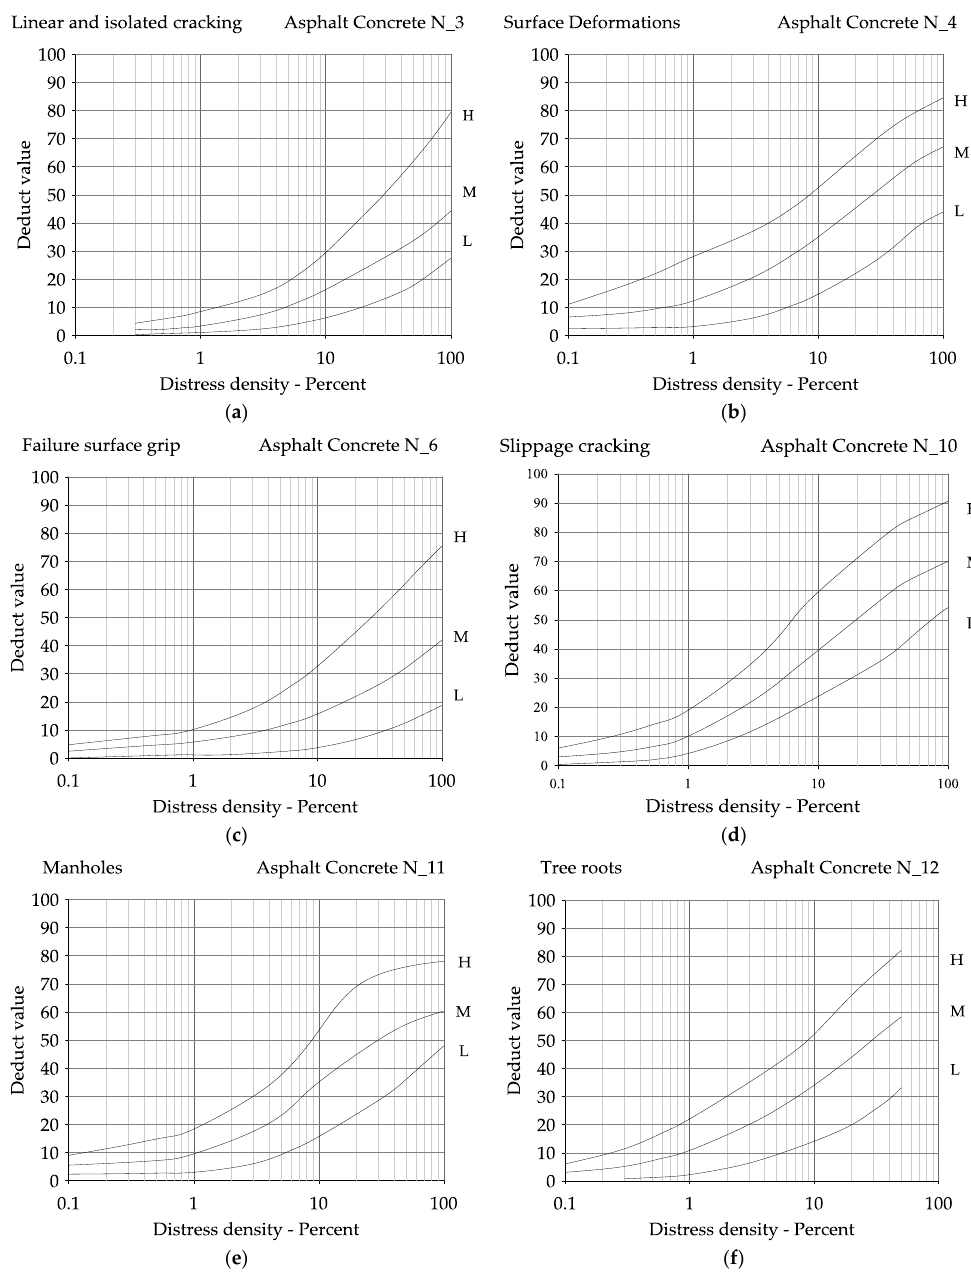
Figure A7. Distress deduct value curves for Urban Distress Identification Catalogue. ( a ) Linear and isolated cracking; ( b ) Surface deformations; ( c ) Failure surface grip; ( d ) Slippage cracking; ( e ) Manholes; and ( f ) Tree roots.